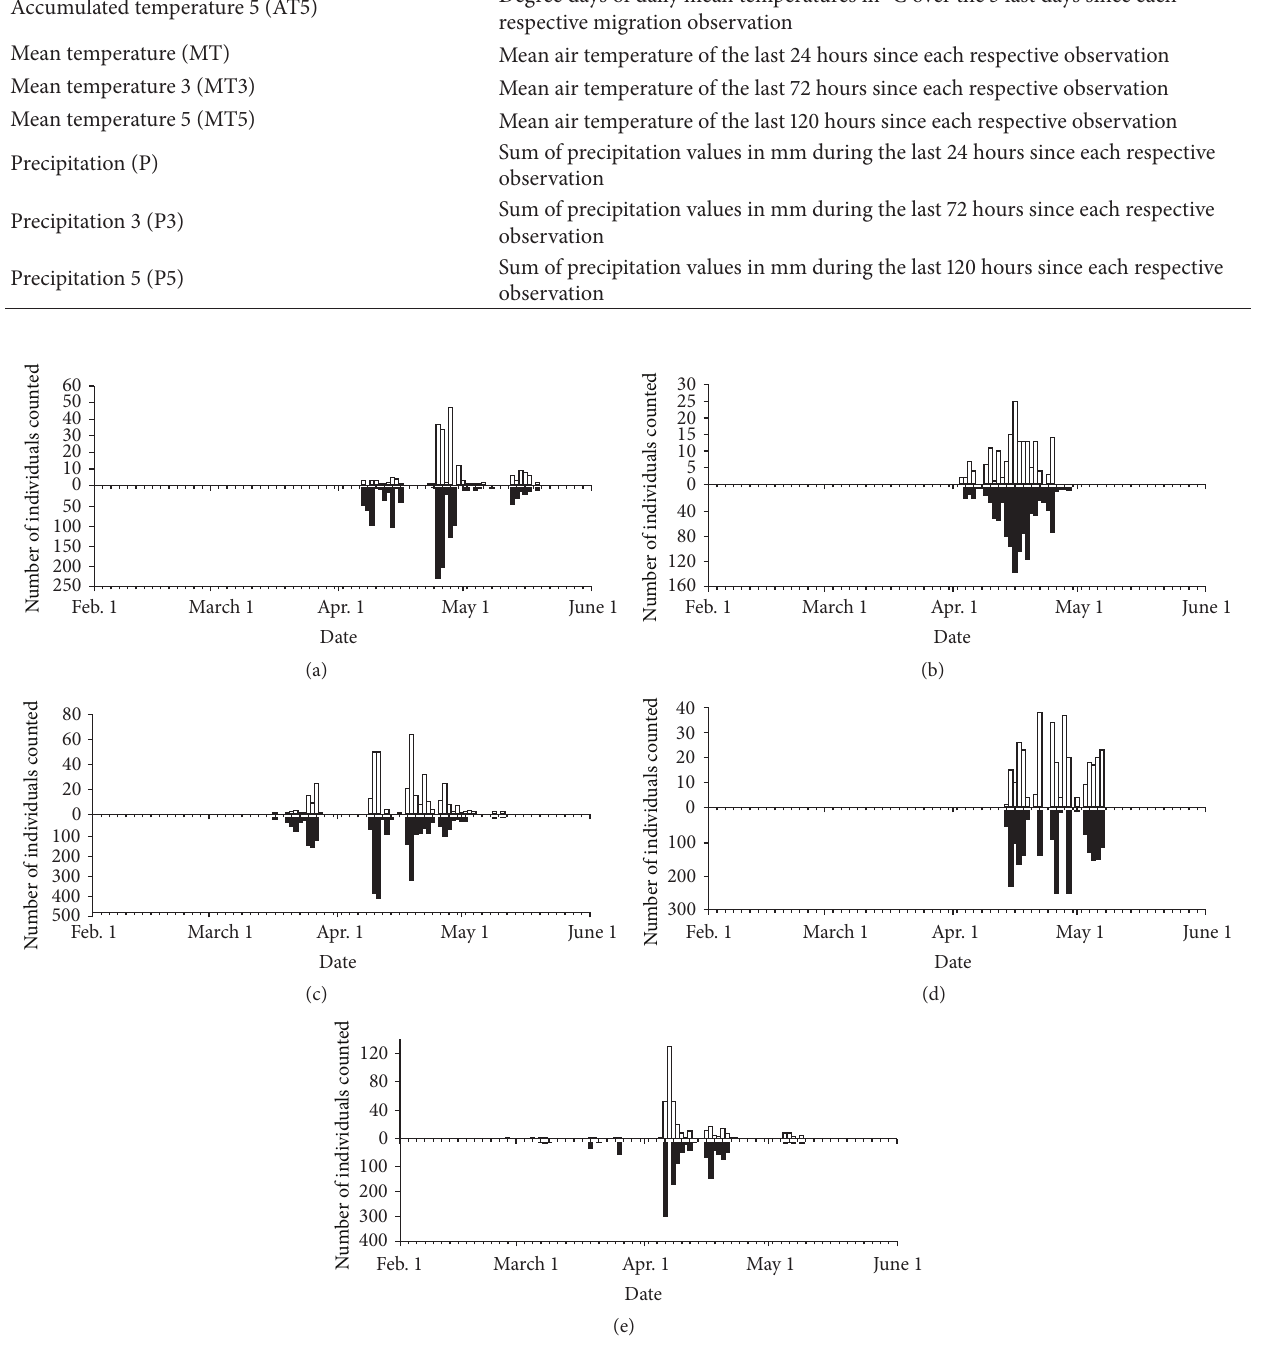
Figure 2: The daily numbers of observed spring migrators of great crested newt T. cristatus (open bars) and smooth newt L. vulgaris (black bars) at Lahelldammen in the period 2010 (a) to 2014